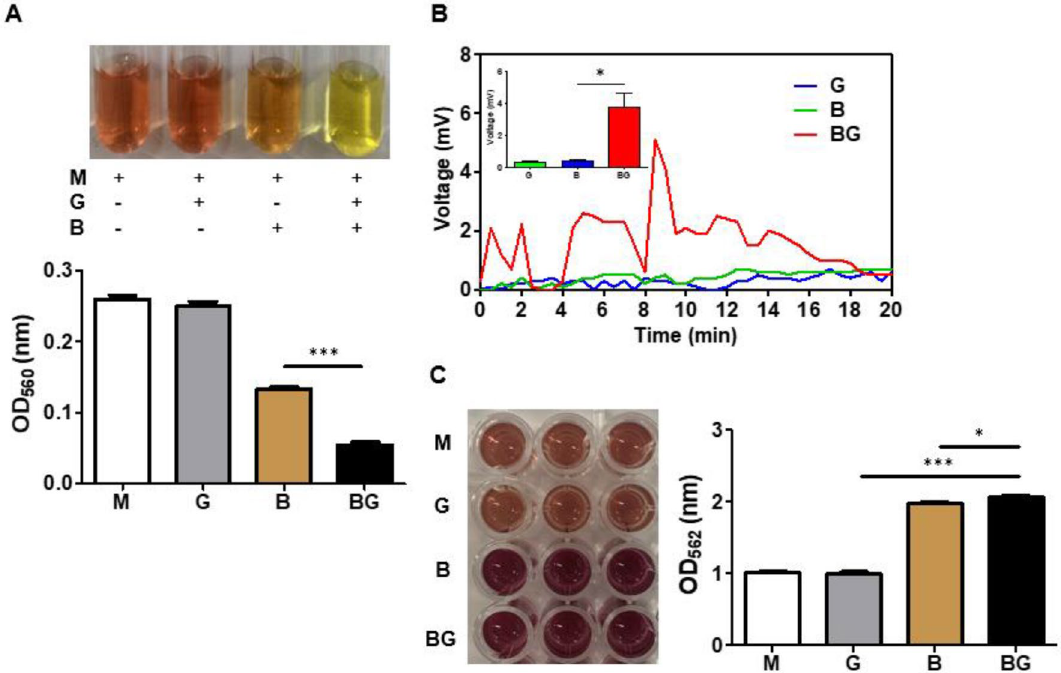
Figure 1. Electricity production and electron transfer by B. circulans produced through glucose fermentation. ( A ) The colour change of phenol red when B. circulans (B) was incubated with/without glucose (G) in TSB medium (M). The OD560 in the media with glucose and B. circulans (BG) was significantly lower than the other groups. ( B ) Voltage changes detection (mV) for 20 min in medium alone or media containing glucose, B. circulans , or B. circulans plus glucose. ( C ) The concentration of ferrozine-chelatable iron (mM) in medium or media containing glucose, B. circulans , or B. circulans plus glucose. Data are expressed as the mean ± SD of three separate experiments. * p < 0.05 and *** p <